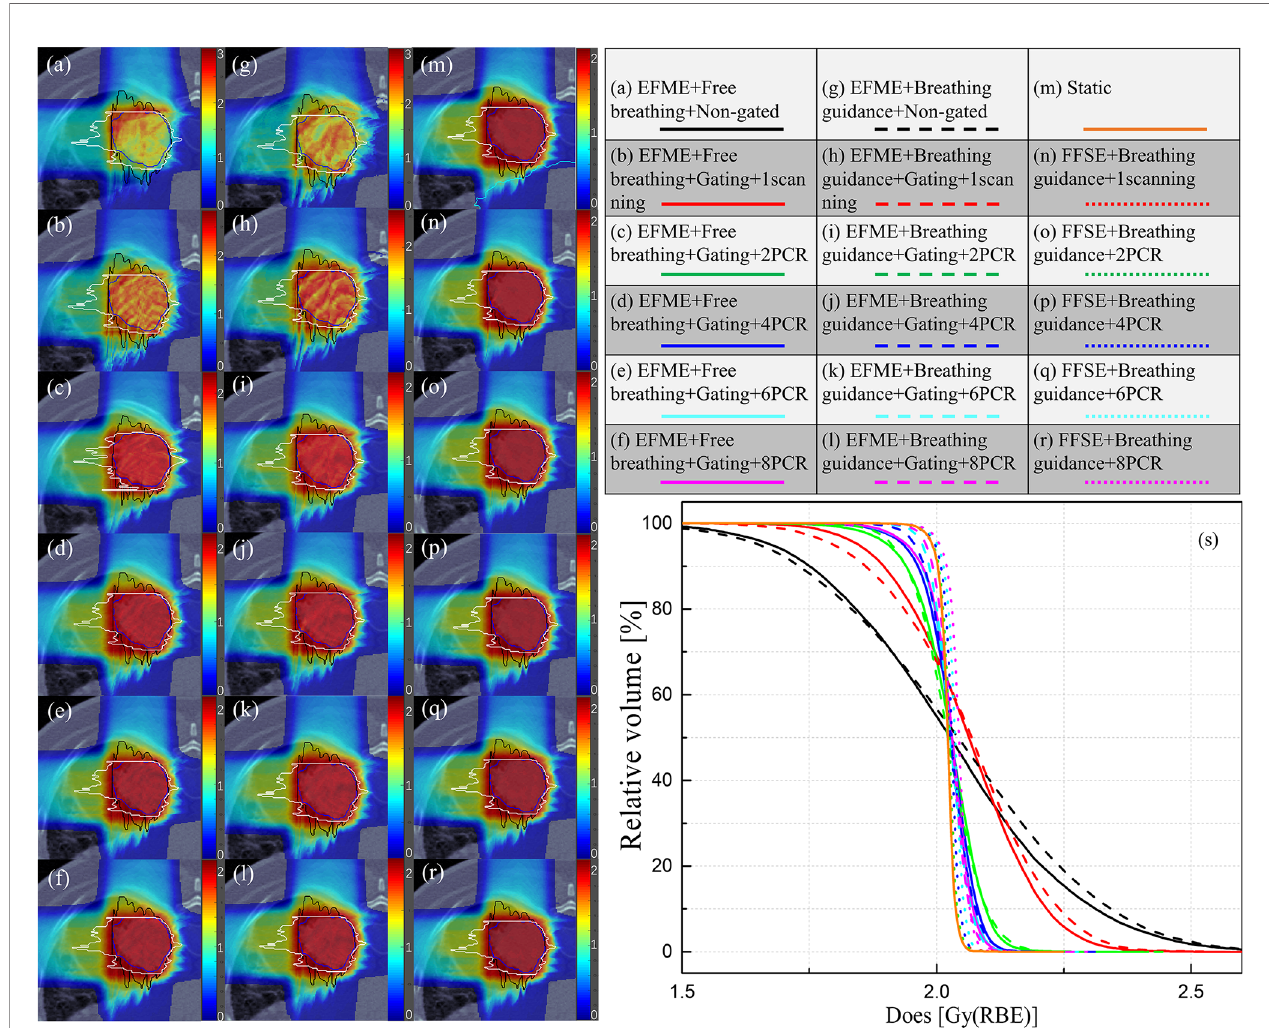
FIGURE 4 | (A – F) 4D dose distributions for a lung cancer case under the non-gated free-breathing and gating with phase-controlled rescanning (PCR) methods delivered in the extended fl attop with multi-energy (EFME) mode. (G – L) Breathing guidance maneuvers in combination with gating and PCR methods under the extended fl attop with multi-energy (EFME) operation. (M) Static case. (N – R) Breathing guidance maneuvers in combination with gating and PCR methods under the fi xed fl attop with single-energy (FFSE) synchrotron operation mode. (S) Corresponding dose – volume histogram bands. Range-adapted internal target volumes (raITVs) are depicted as black and white lines for each irradiation fi